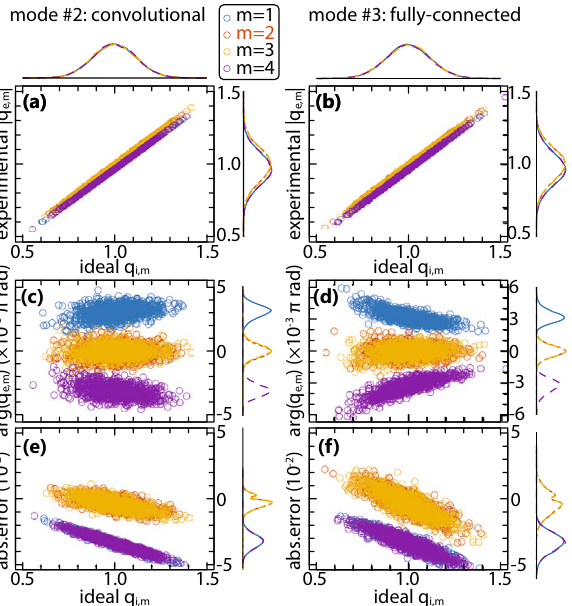
Figure 4. Comparison between the convolutional (#2, left-hand-side) and the fully-connected (#3, right-hand- 4 channels, optimized for operation at channel c side) mode of PPNN operation with M = 15dB . Channel-wise color coded 2-D scatter plots of the targeted 0.8nm and R AWG axons for (cid:31) (cid:31) 1 = − = matrix element q t, m and ( a ), ( b ) the magnitude and ( c ), ( d ) the argument of the experimental matrix